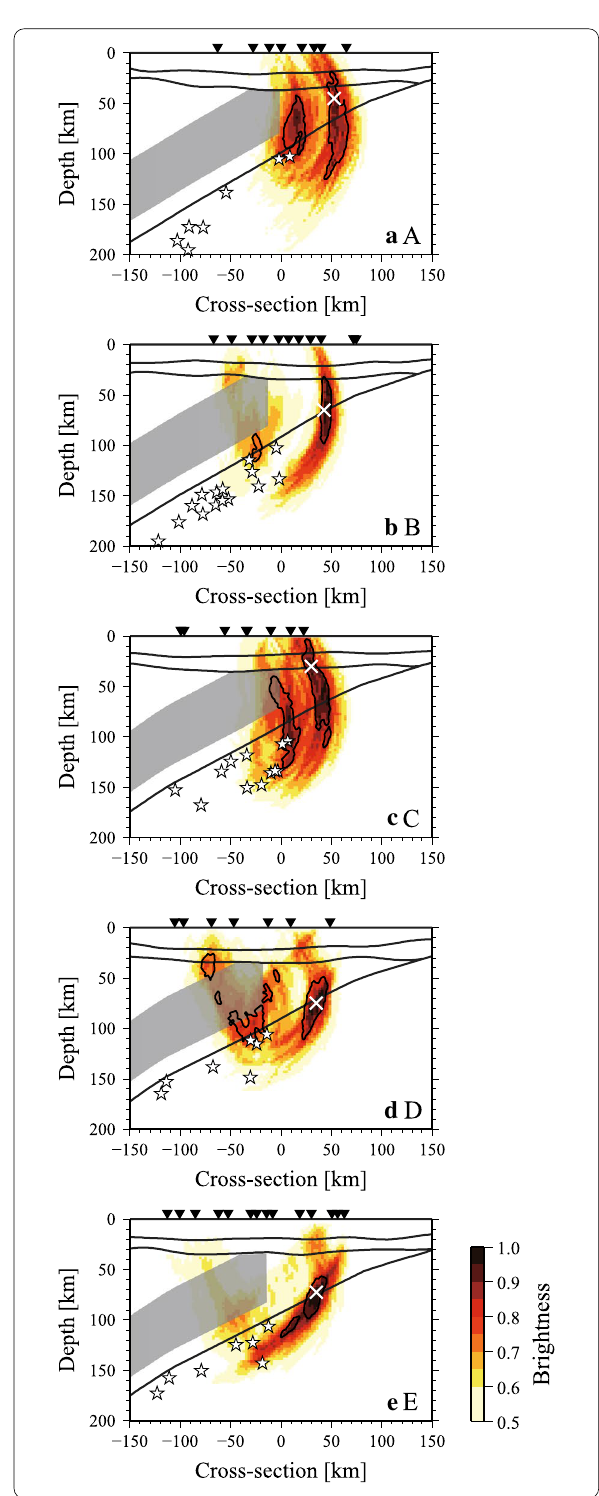
Fig. 5 Estimated locations of passing points from the backarc intraslab earthquakes. White crosses and black contours indicate the passing points defined by the maximum brightness values, B , and the 95% confidence intervals, respectively. Stars and inverted triangles denote the earthquakes and stations, respectively. Gray-shaded areas represent the high-attenuation zone in the mantle wedge. Black lines depict the structural boundaries shown in Fig. 4